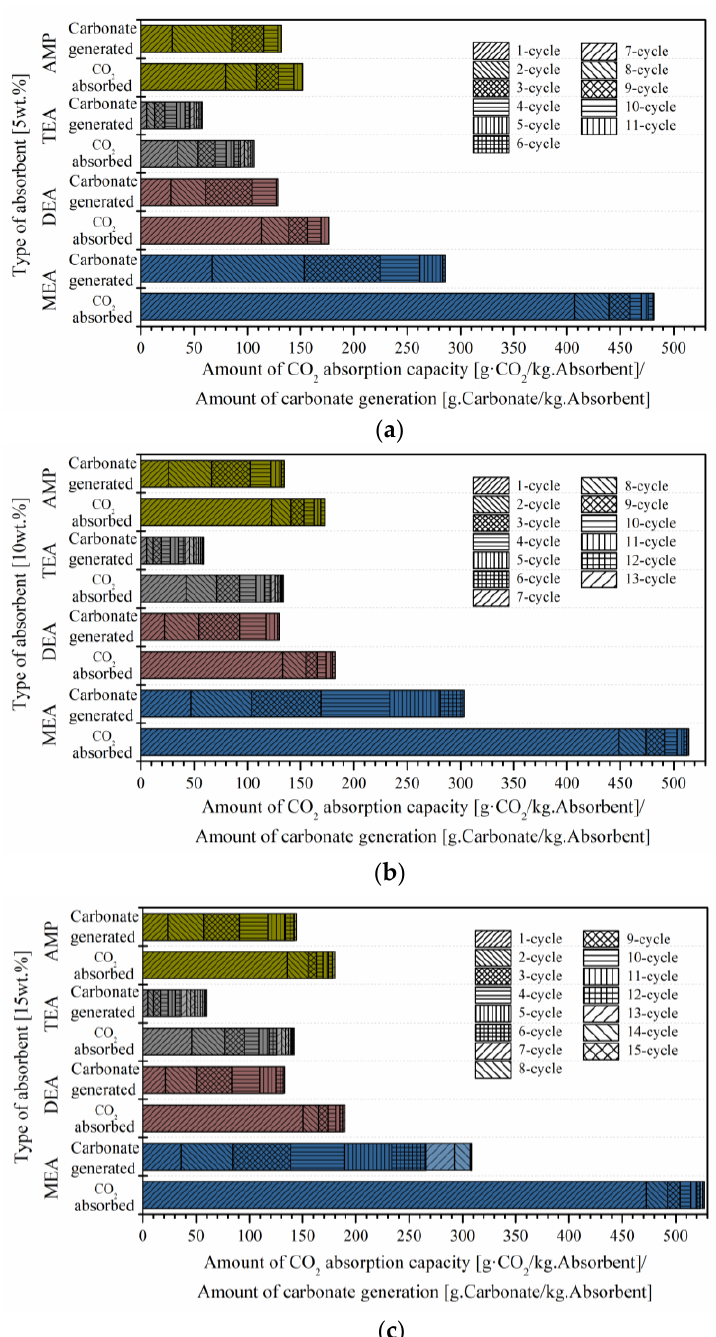
Figure 4. Amount of CO 2 absorption capacity and amount of solid carbonate of MEA, DEA, TEA, and AMP absorbents in multicycle IAM for ( a ) 5, ( b ) 10, and ( c ) 15 wt.% absorbent concentrations.